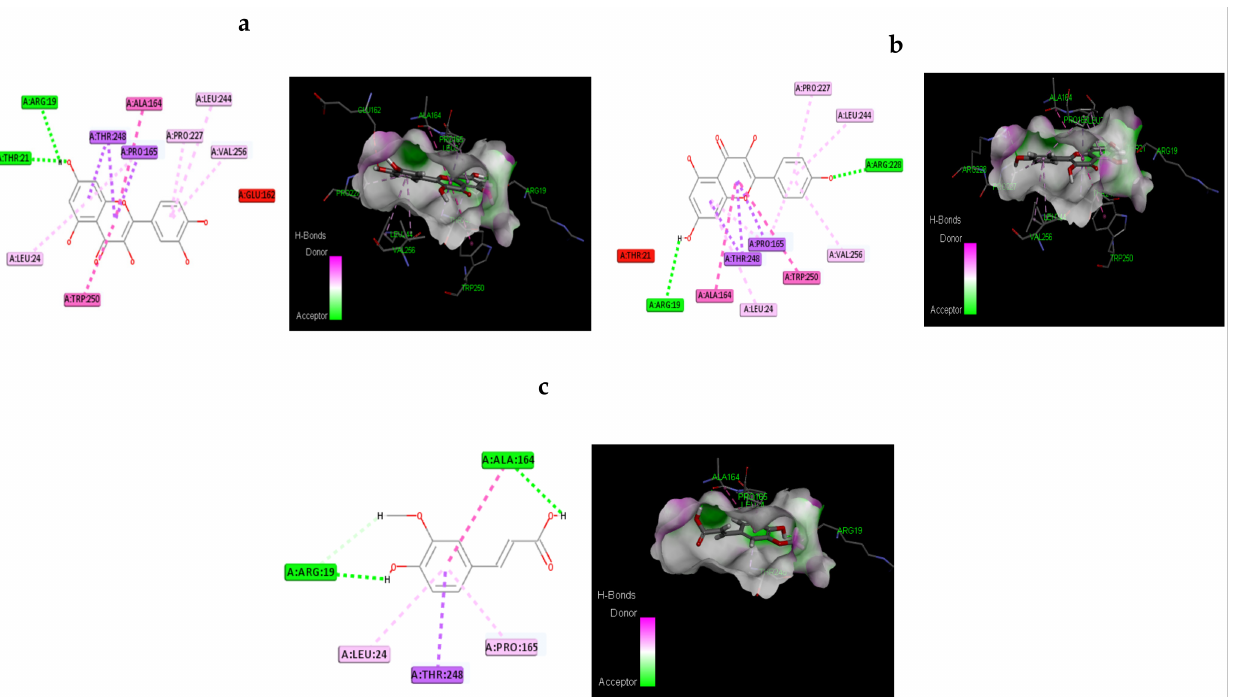
Figure 12. Molecular Interaction of the best three compounds with GLUT-4: ( a ) Quercetin, ( b ) Kaempferol, and ( c ) Trans-Ferulic